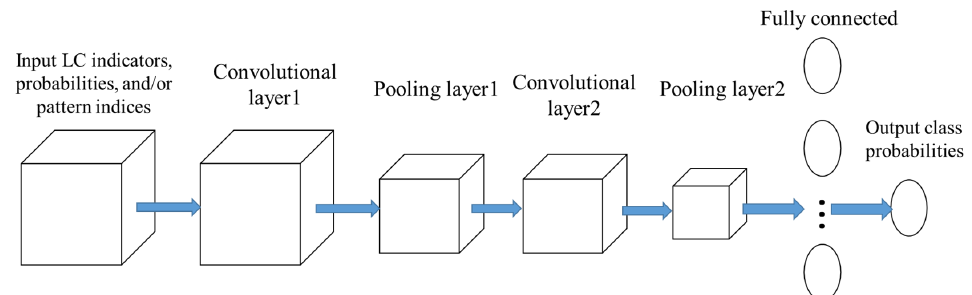
Figure A1. The network architecture of the convolution neural network used in this